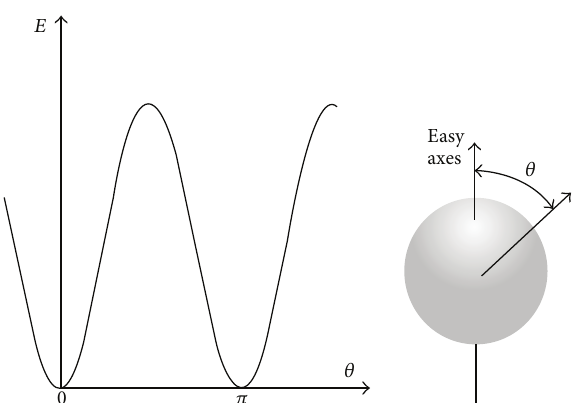
Figure 6: The schematic of variation of anisotropy energy as a function of moment vector directions. In easy axes (in this figure: 0 and 𝜋 angles) the anisotropy energy is minimum and in hard axis ( 𝜋/2 ) it is maximum amount [60].